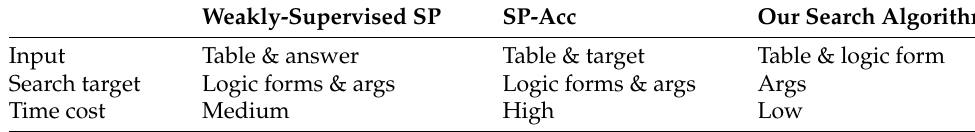
Table 5. Comparison of different search